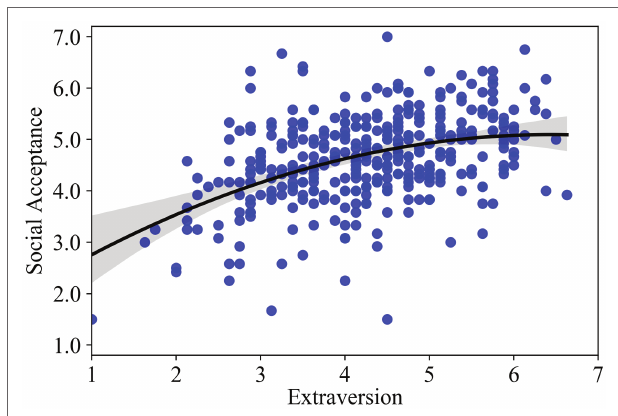
FIGURE 1 | Curvilinear relationship between extraversion and social